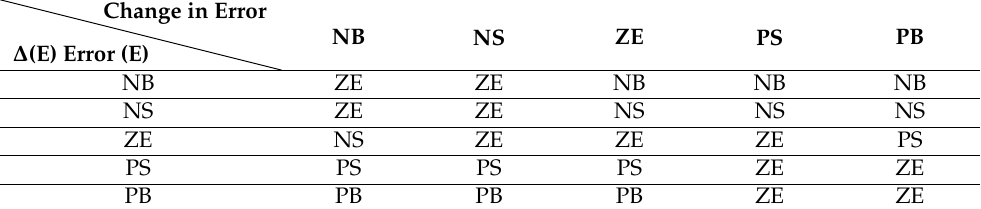
Table 4. Fuzzy Logic Rule